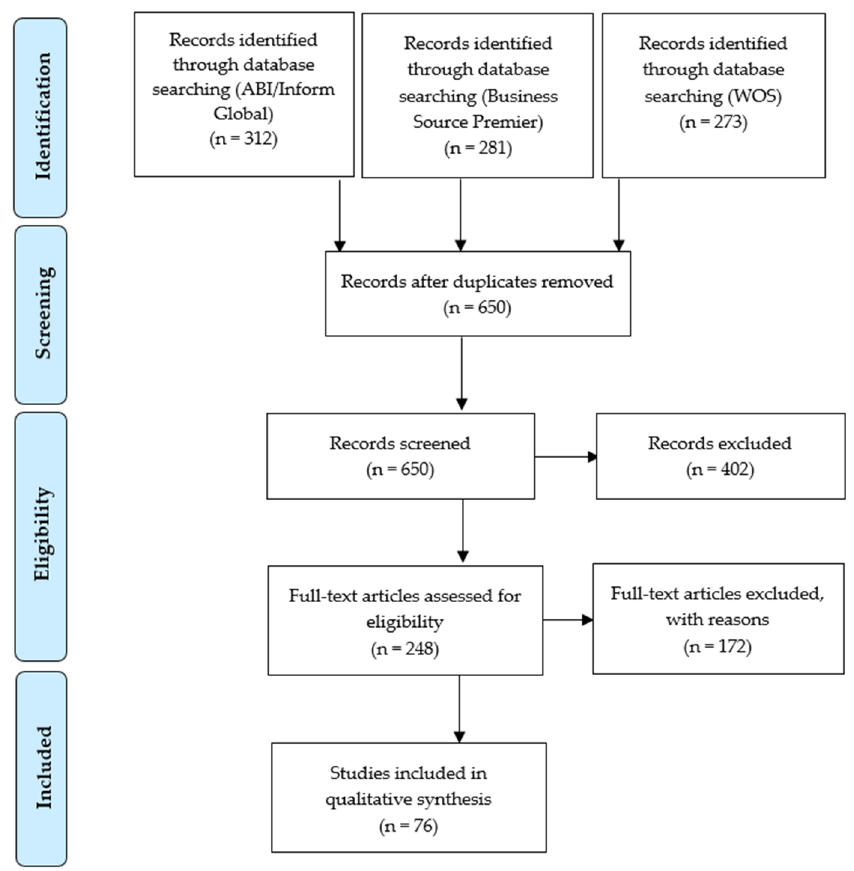
Figure 1. PRISMA flow diagram.